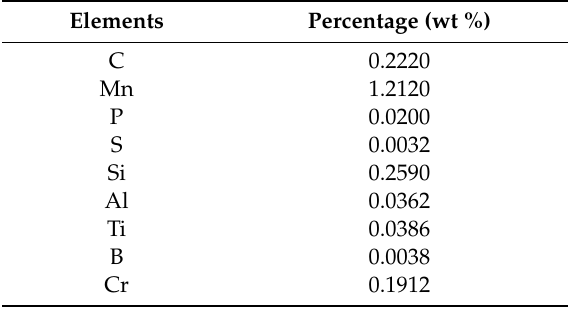
Table 1. Material composition of USIBOR ® 1500 high-strength